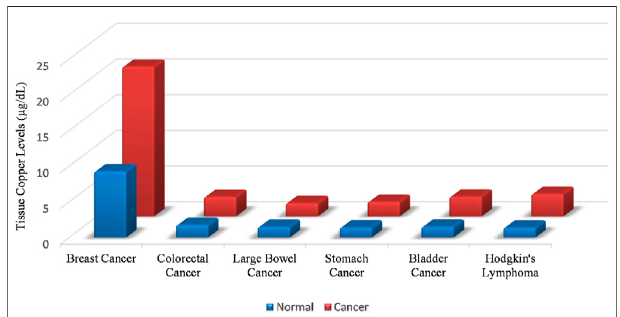
FIGURE 1 | Tissue copper levels are elevated in malignancies as compared to normal tissue. This rise in cellular copper is independent of the cellular origin of the